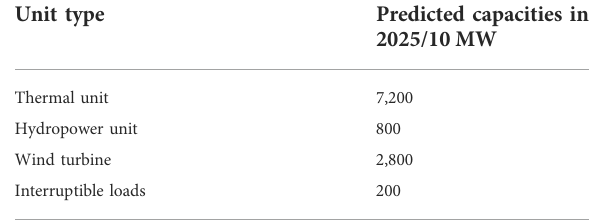
TABLE 1 Predicted generation and interruptible load capacities in 2025.